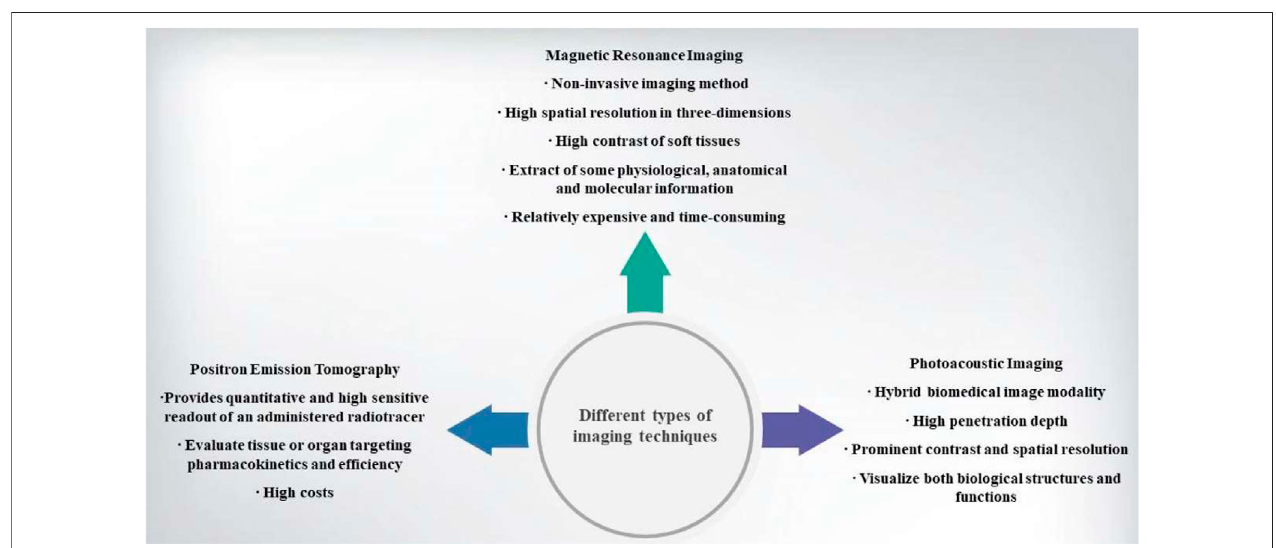
FIGURE 3 | Diagram of the different types of imaging